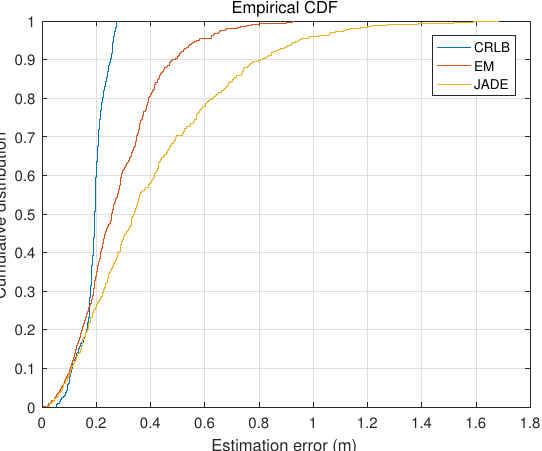
Figure 3. The cumulative probability–distribution curves of localization